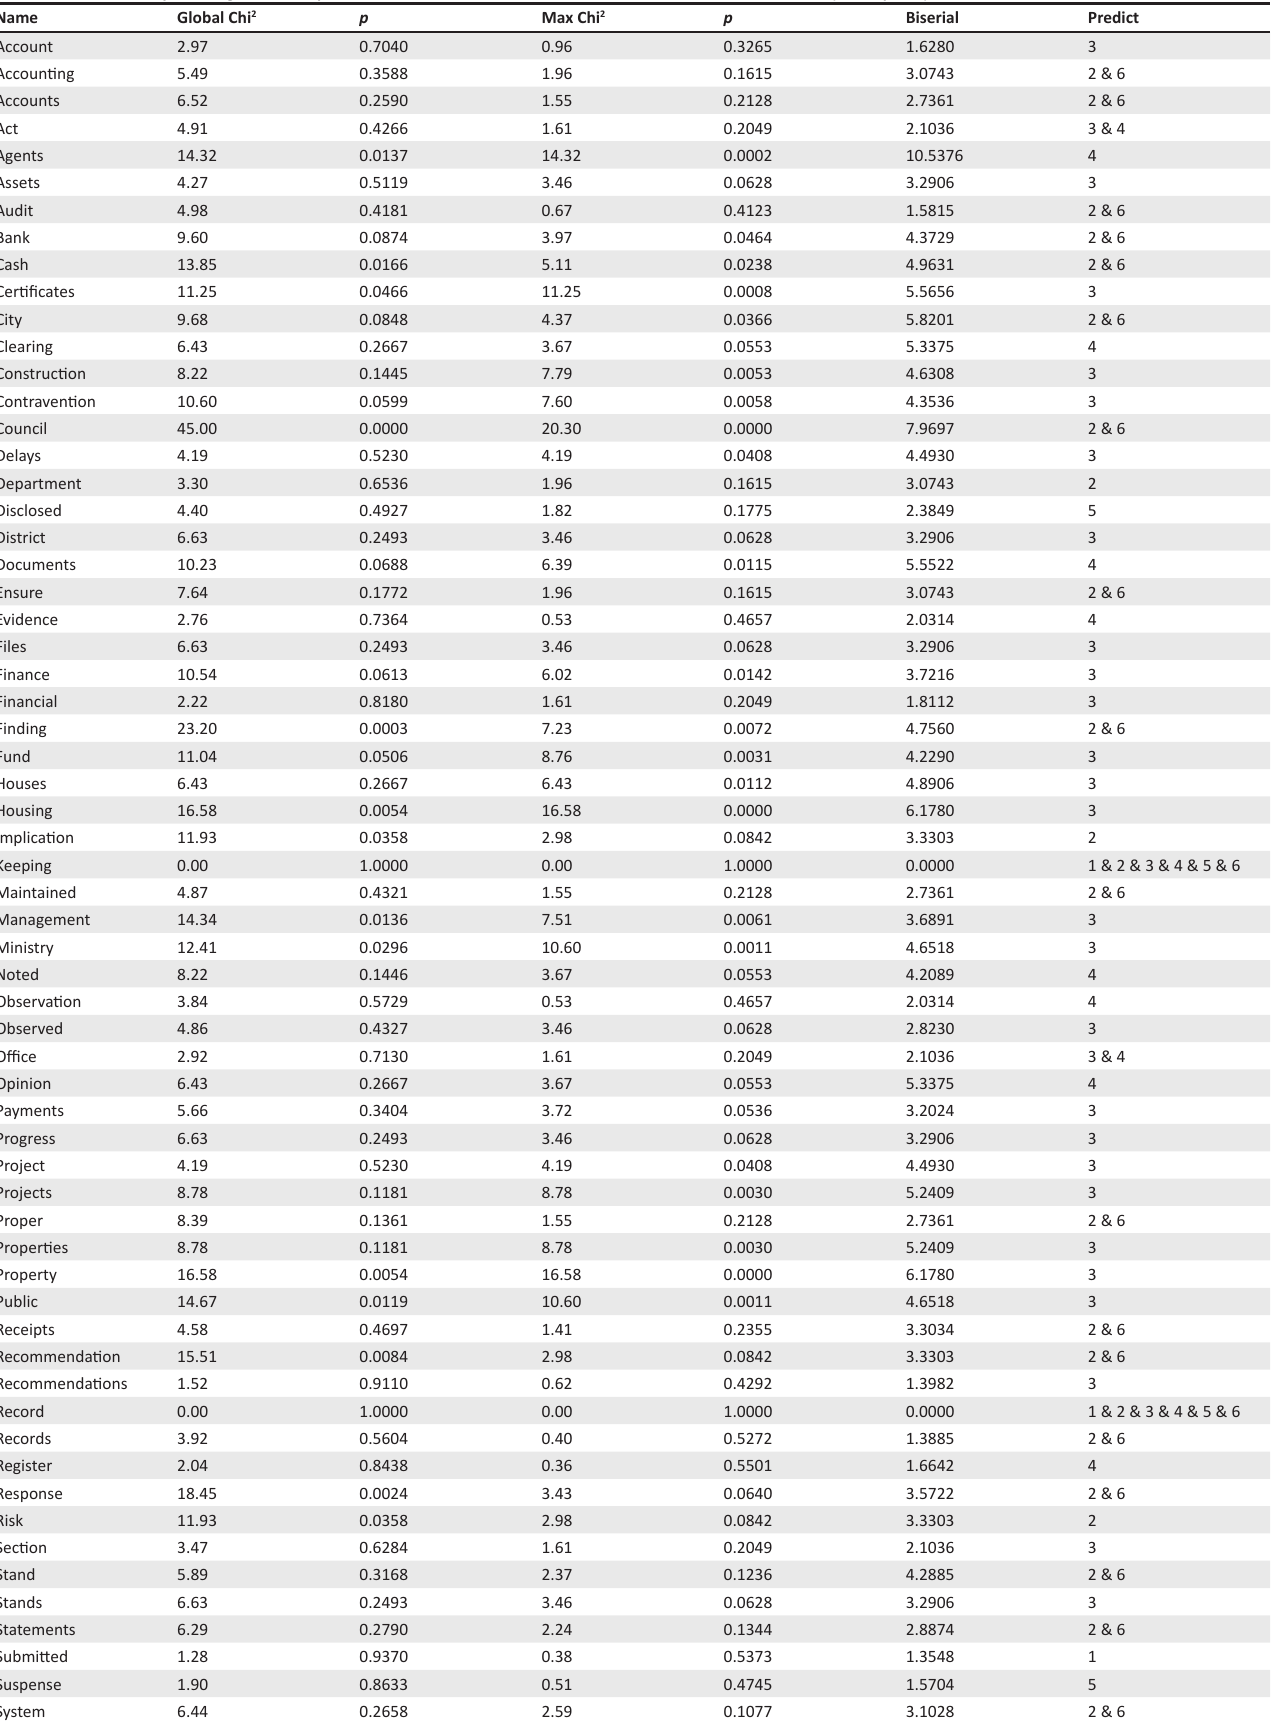
TABLE 4: Metrics analysis using statistical predictors for the occurrence of the word ‘record’ within six cases (the